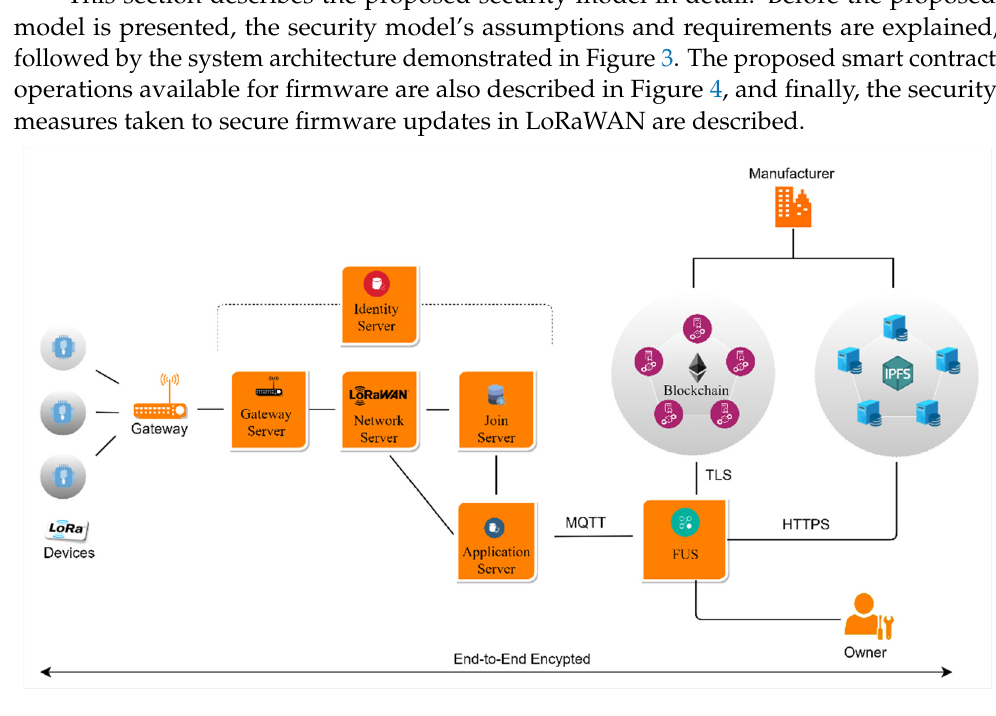
Figure 3. The System Architecture of the Security Model.